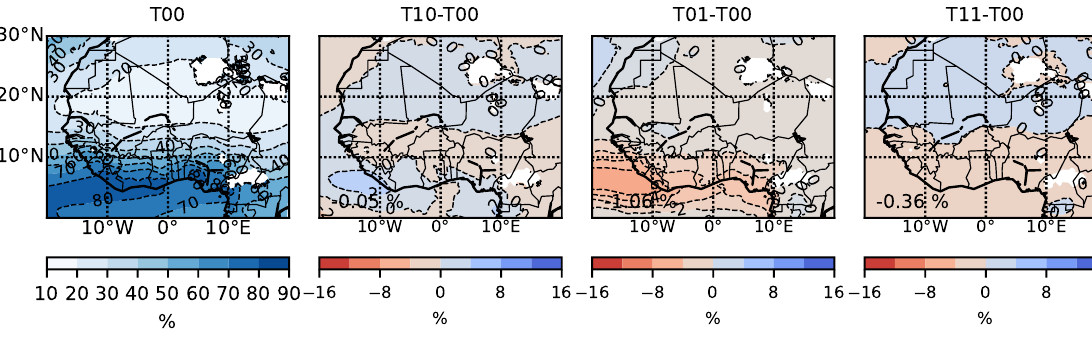
Figure A3. JAS 925 hPa relative humidity for the control simulation and sensitivity experiment